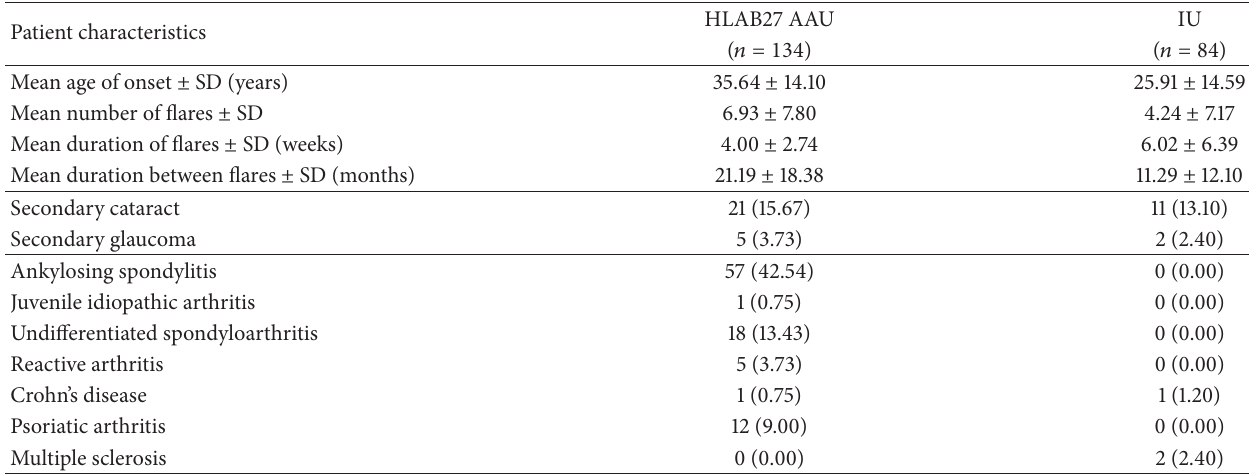
Table 2: Baseline ocular and systemic